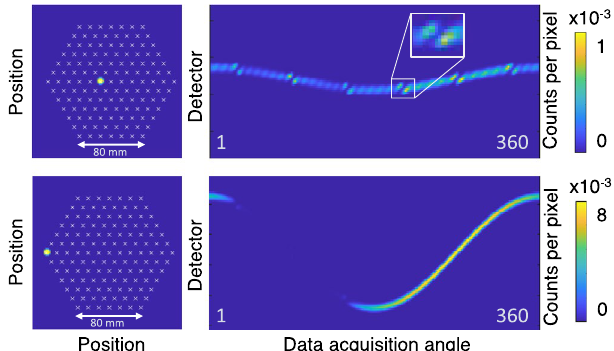
Figure 9. Activity images for two single emitting rod sinogram calculations are shown on the left, an emitting rod near the center (top row) and an emitting rod at the outer edge of the assembly (bottom row). White crosses mark the fuel rod centers for the rods that only attenuate. These activity images are a basis for the sinograms shown on the right, constructed with the forward model used in the reconstructions. Note the scale of the counts values (only 8 times more for the rod at the outer edge). The inset shows a zoom-in around the position of see-through